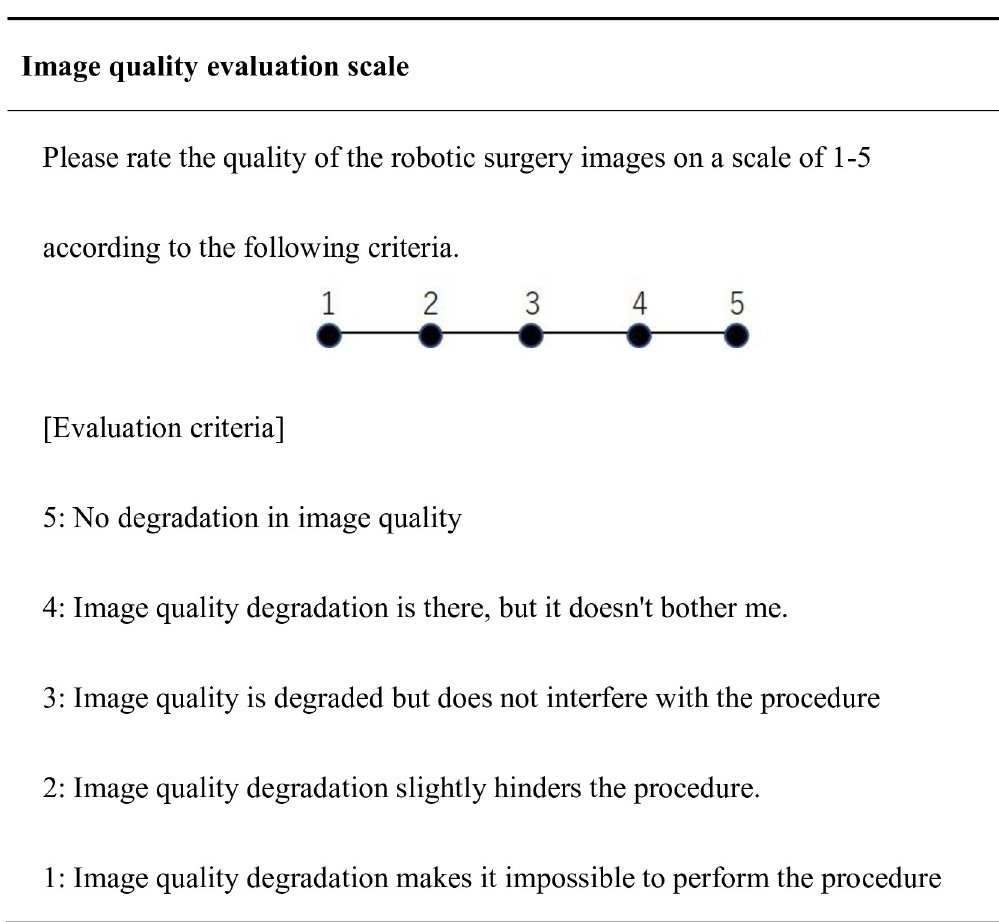
Fig 5. Image quality evaluation